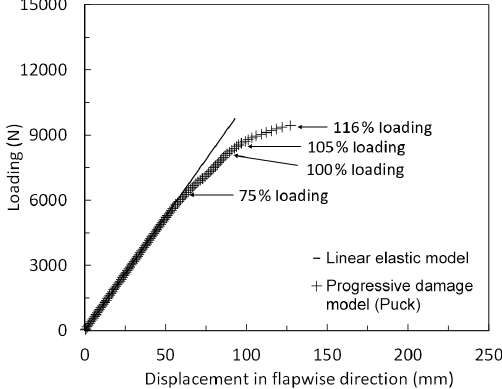
Figure 15. Load–displacement curves of the blade using the linear elastic model and progressive damage model (Puck) under extreme flapwise loading.